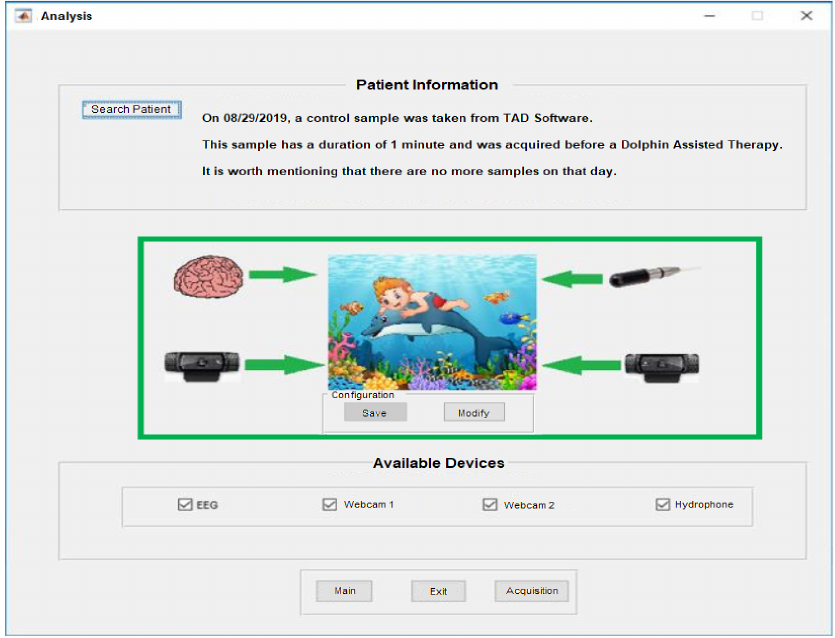
Figure 19. System configuration for the case